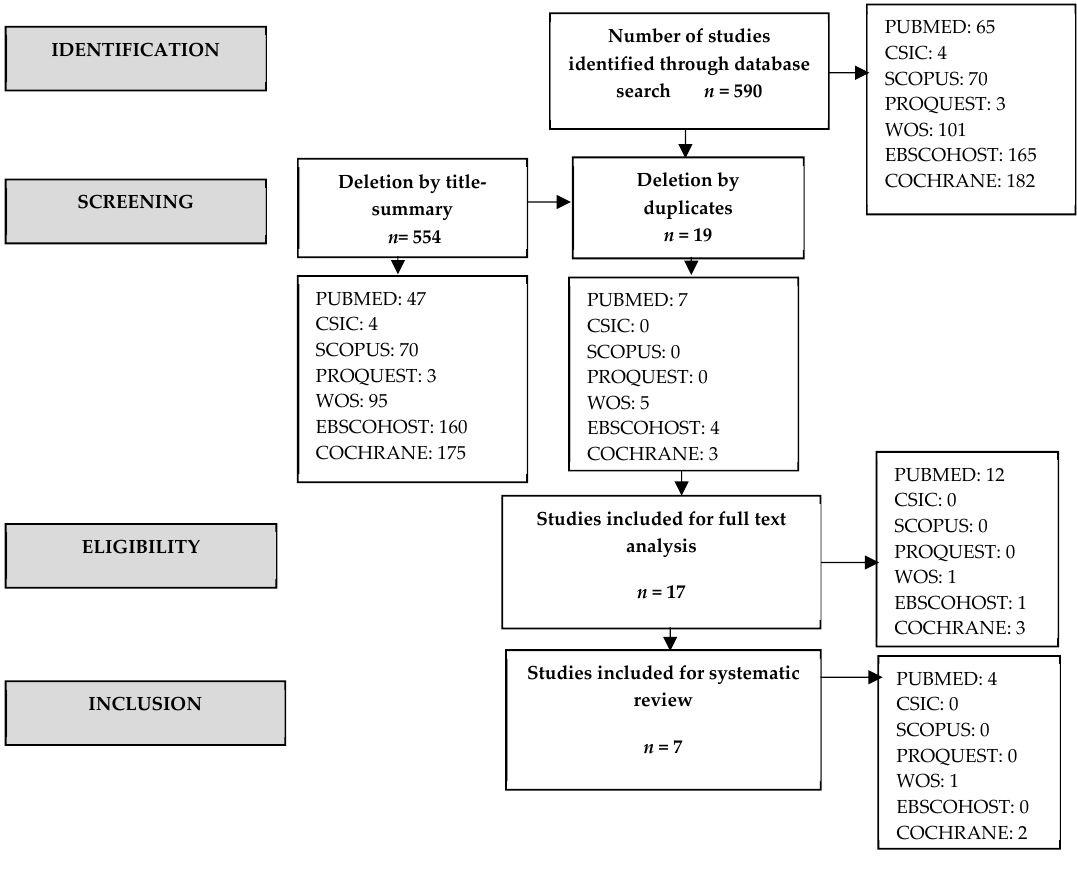
Figure 1. Prisma flow chart.